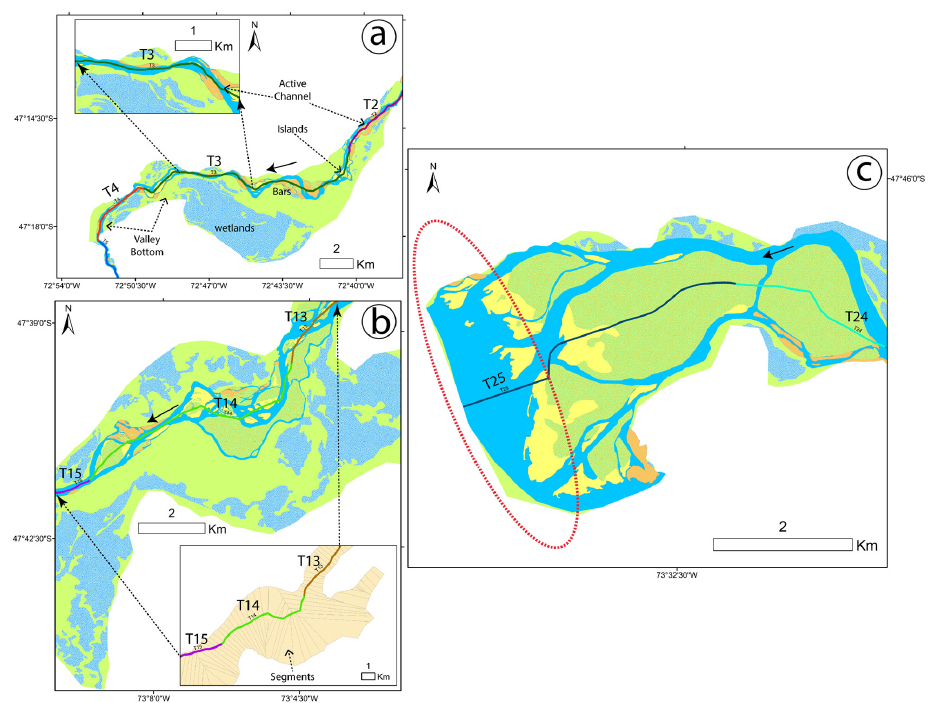
Figure 16. Baker case study: ( a ) details related to reach T3 (top left, denoted as 23 in Figure 14); ( b ) T14 (bottom left): no novelties are introduced by the VB width change criterion. Flow direction follows increasing reach numbers and ( c ) Baker case study: the last reach deserves further splitting (North on